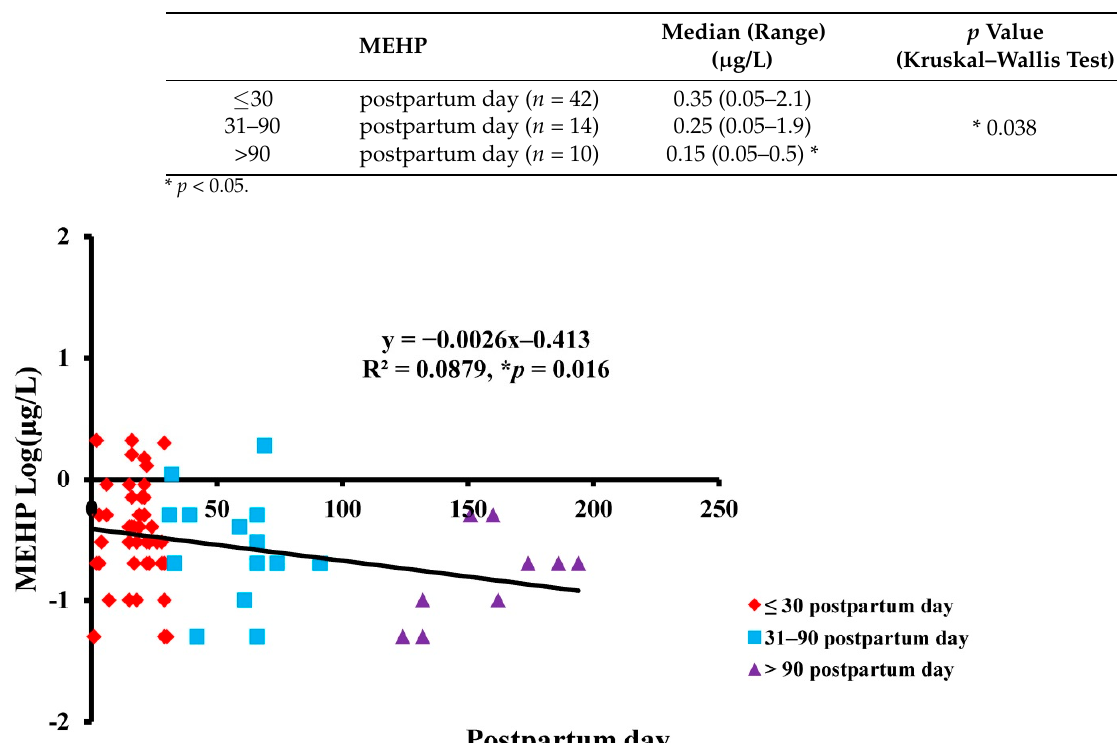
Table 4. MEHP levels in breast milk during different postpartum periods.